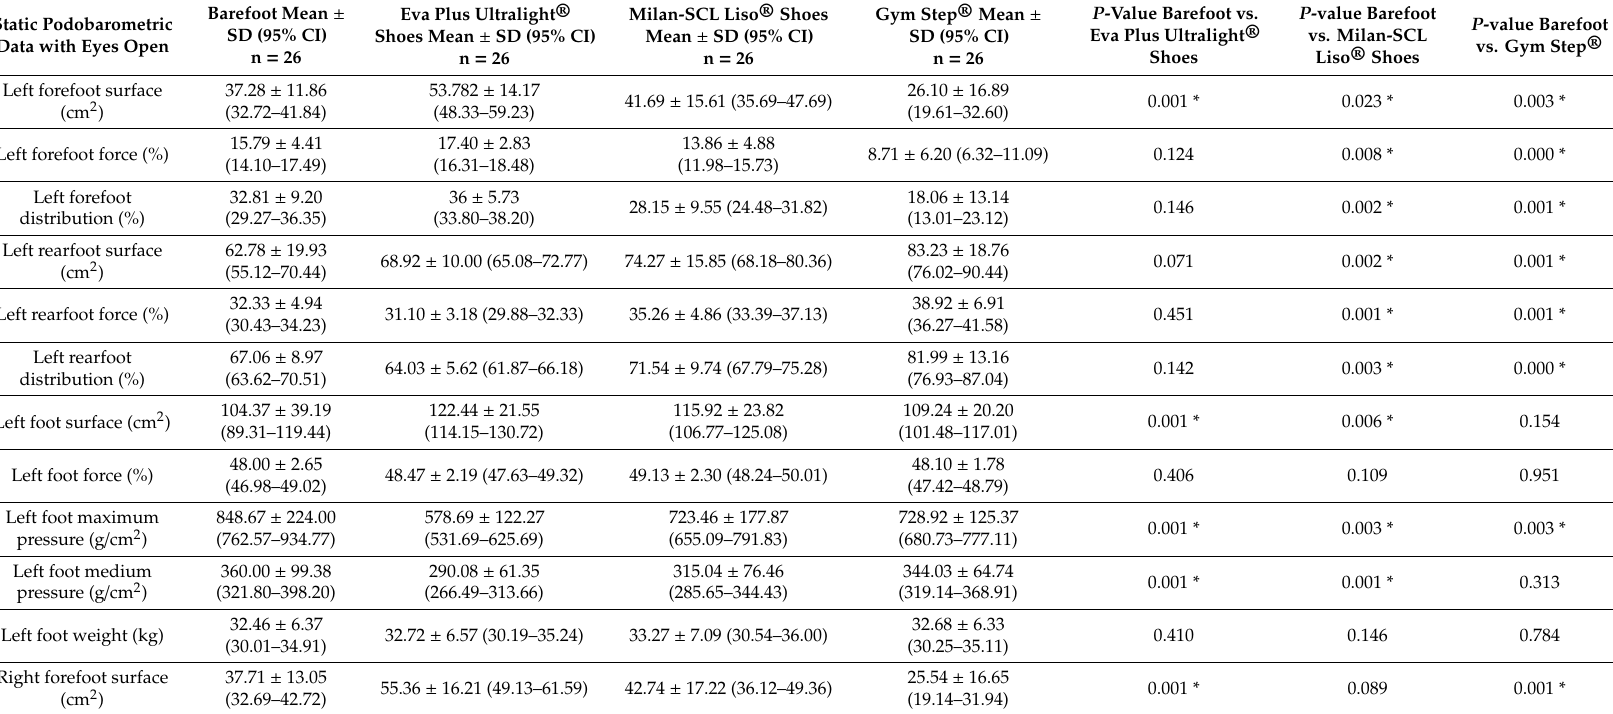
Table 4. Comparison of the static podobarometric data with eyes open between